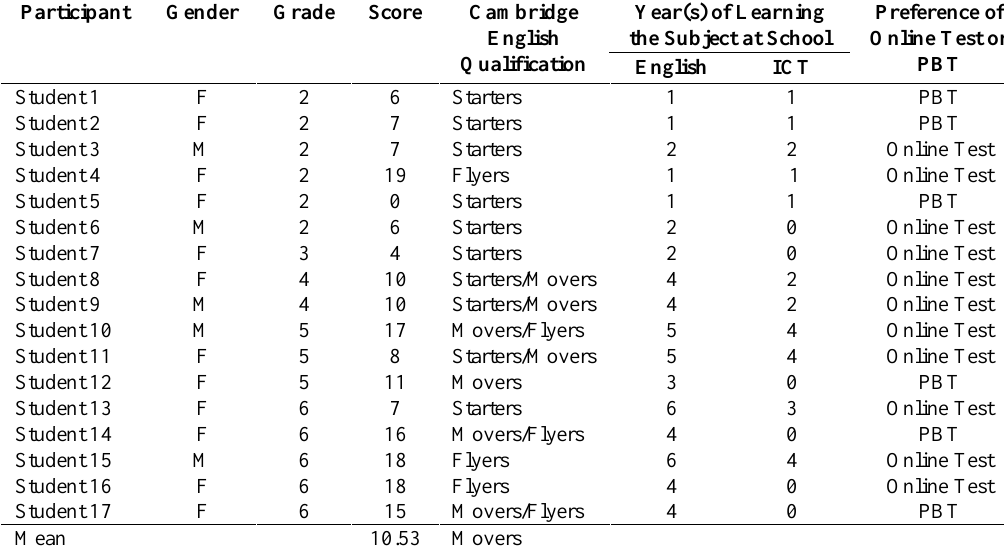
Table 2. Participants’ Test